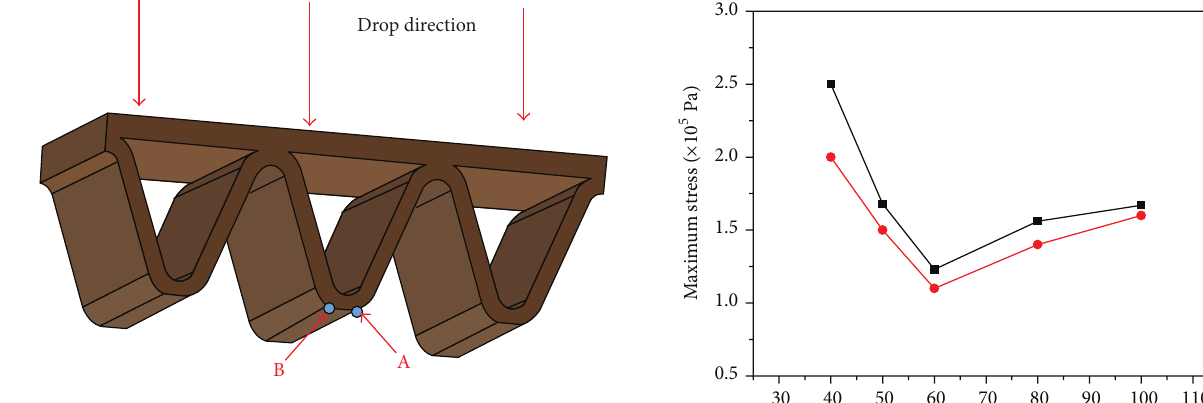
Figure 17: The drop test model with different flute angle 𝜃 .